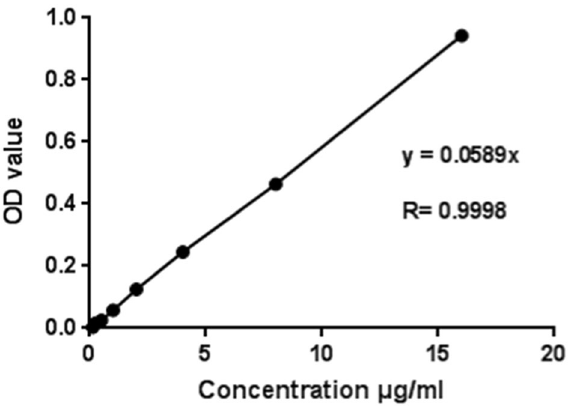
Figure 2. Evans Blue standard